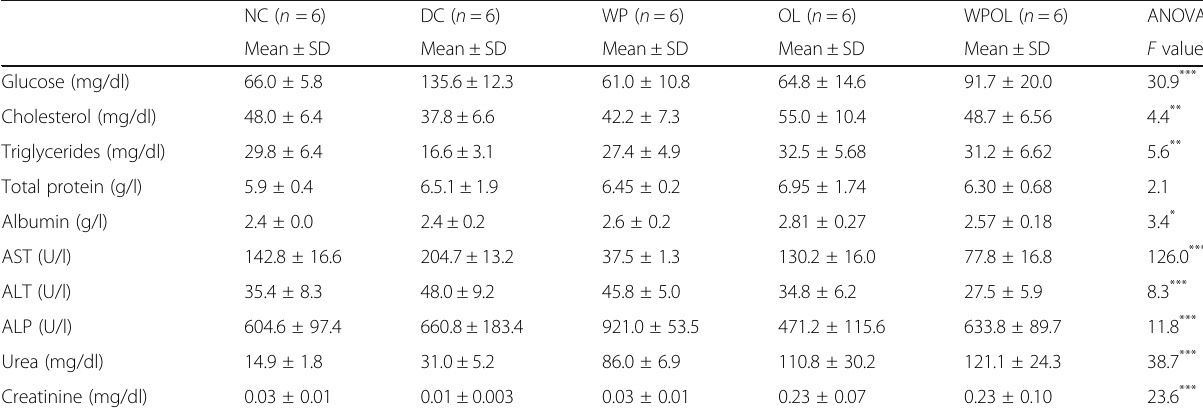
Table 3 Mean ± SD of biochemical markers of diabetic rats fed on whey protein, olive leaves extracts and their mixture